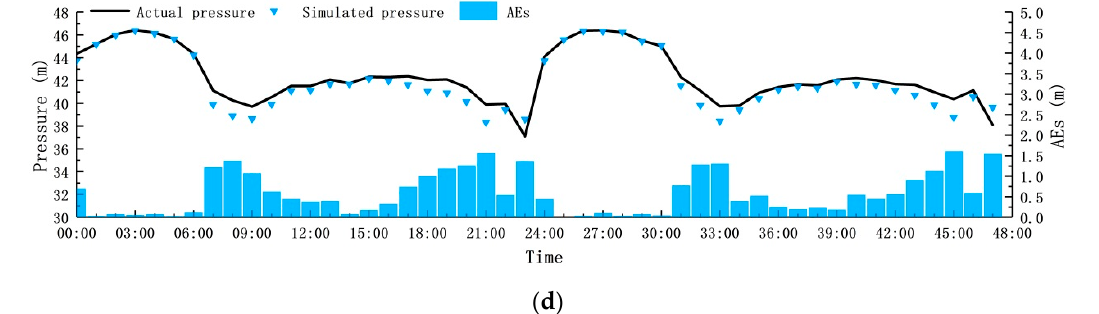
Figure 6. Comparisons of actual pressures and simulated pressures at four points: ( a ) Node 217; ( b ) Node 506; ( c ) Node 544; ( d ) Node 619.